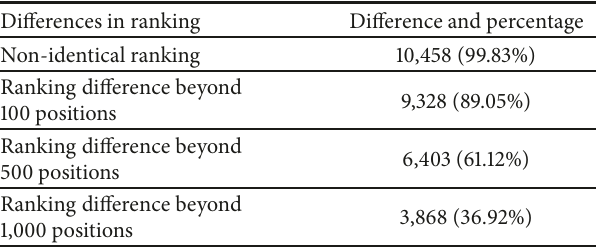
Table 12: Differences in ranking between the reported AVC and the carcass removal using the GNB-based EB estimates.